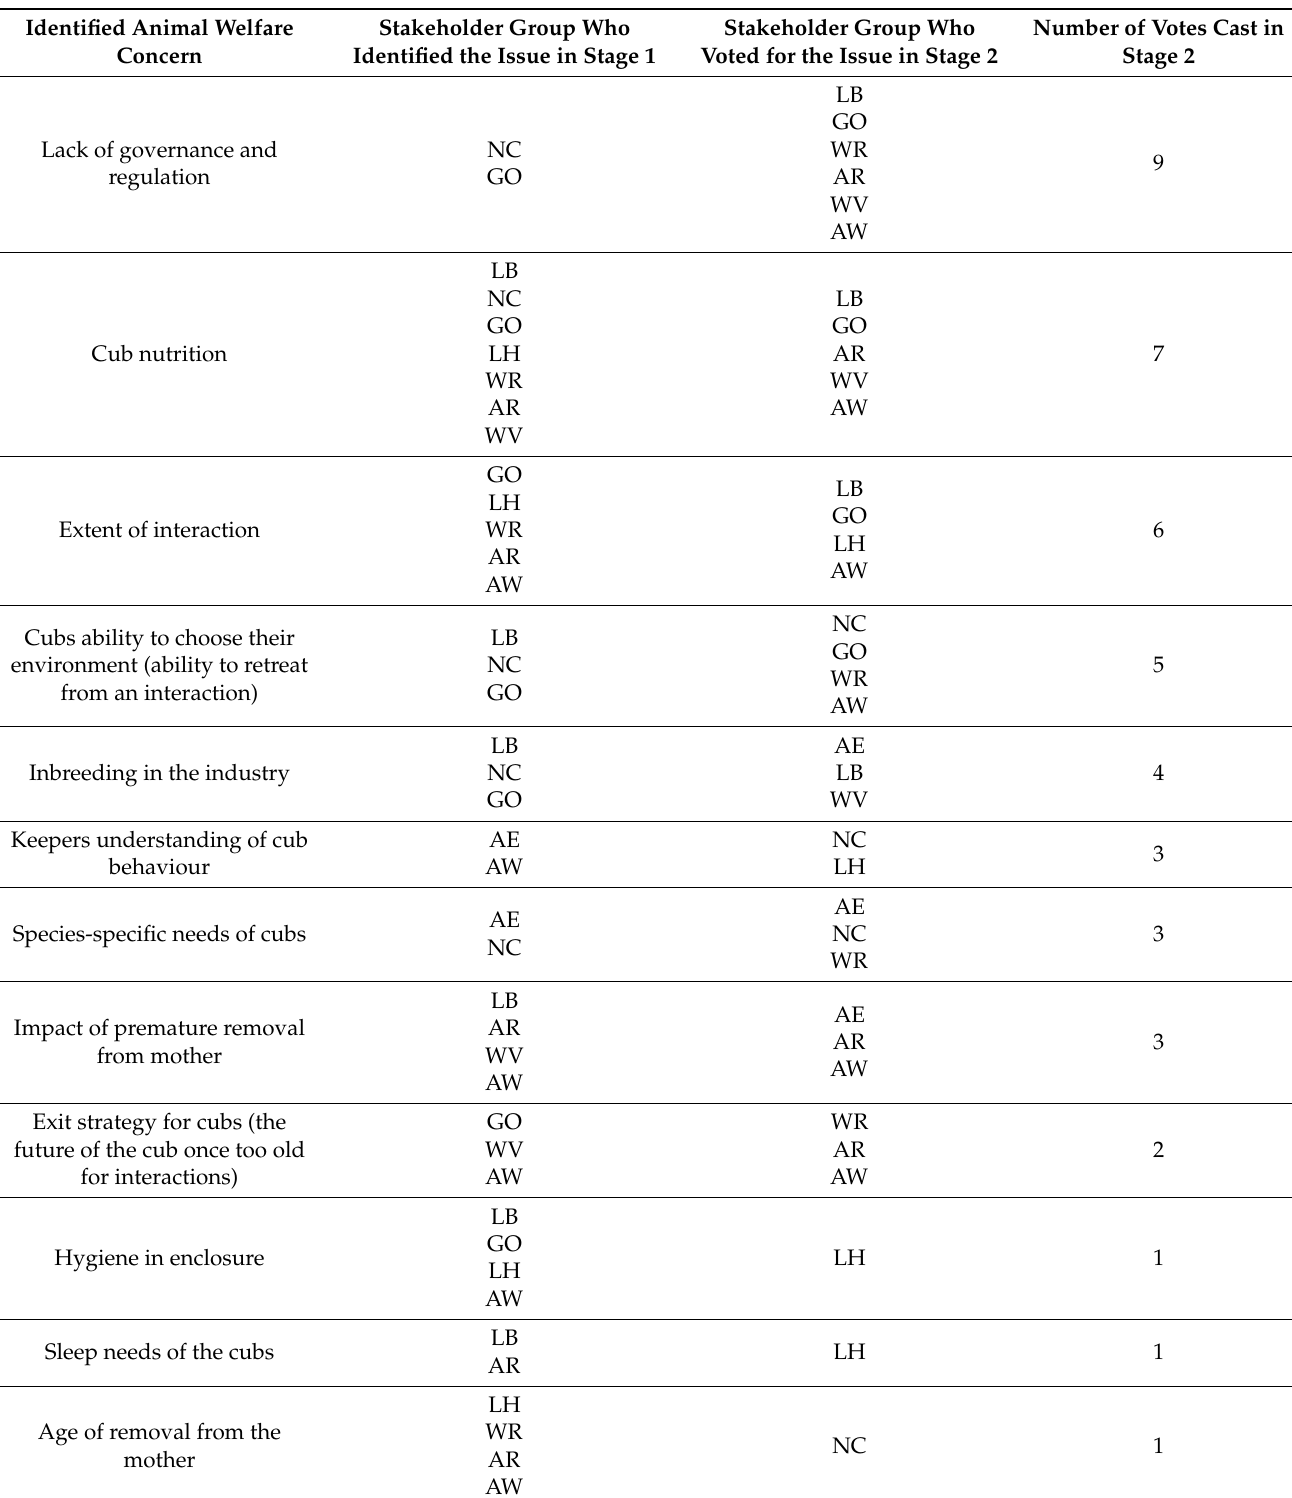
Table 1. Animal welfare concerns identified in Stage 1 and the stakeholders who identified them, listed in declining order of support in Stage 2 (Abbreviations: nature conservationist (NC), government organisation official (GO), wildlife rehabilitator (WR), animal rights advocacy representative (AR), wildlife veterinarian (WV), animal welfare organization representative (AW), lion breeder (LB, lion handler (LH), animal ethologist (AE)). Identified Animal